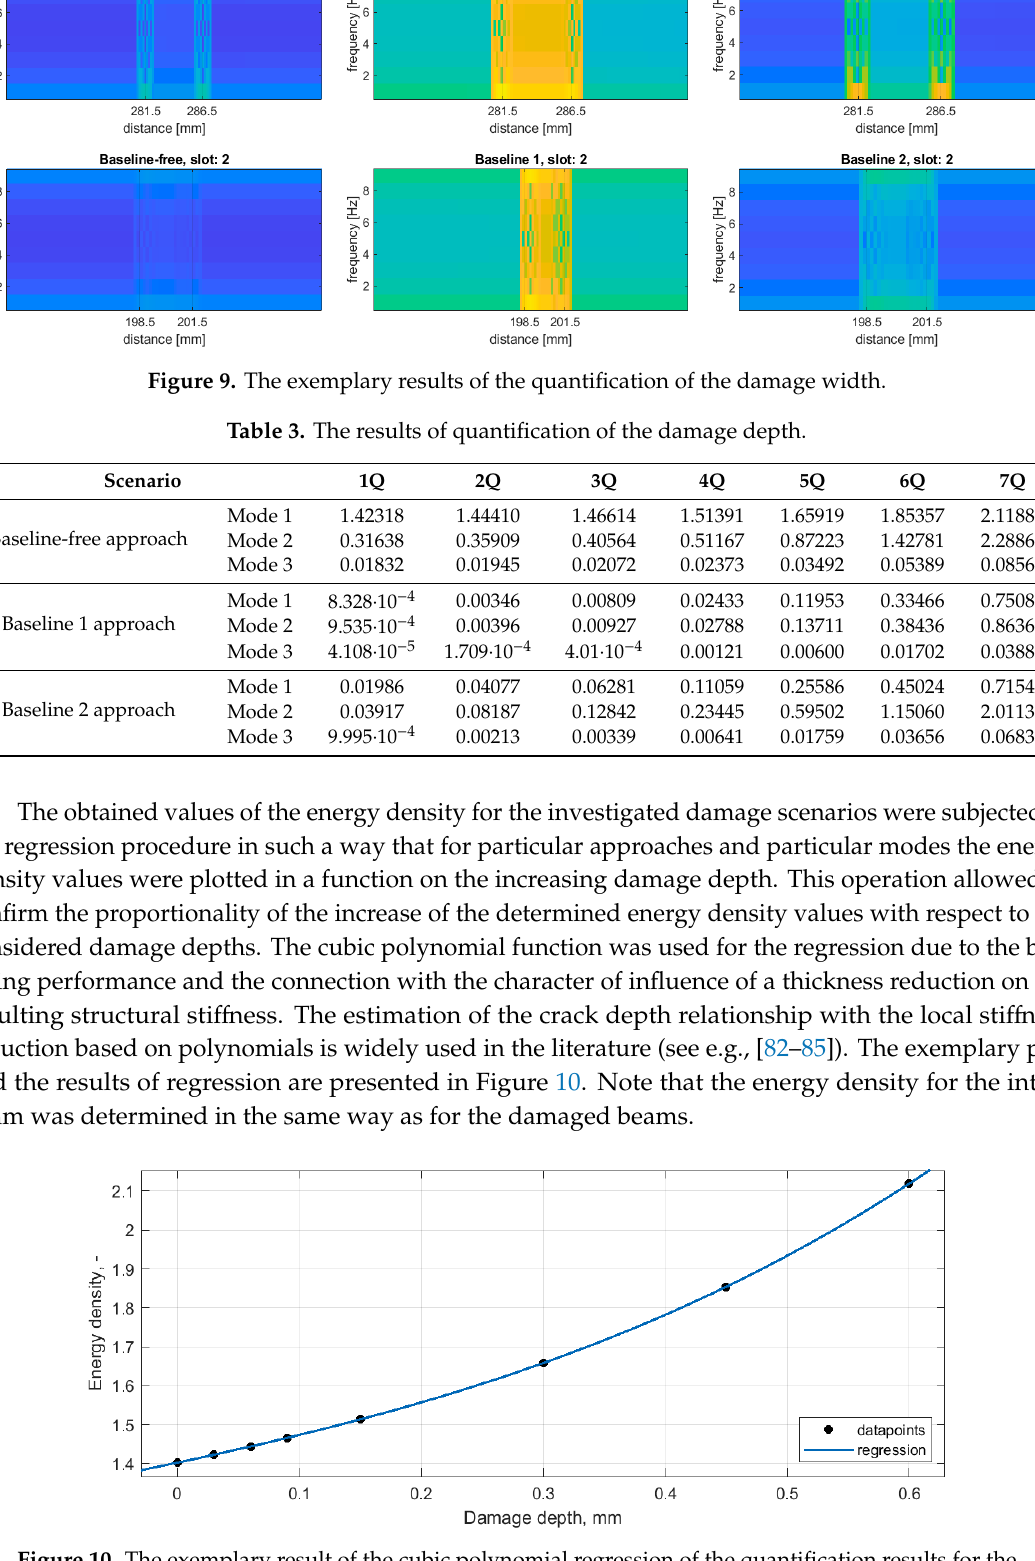
Figure 10. The exemplary result of the cubic polynomial regression of the quantification results for the mode 1 of the baseline-free approach.